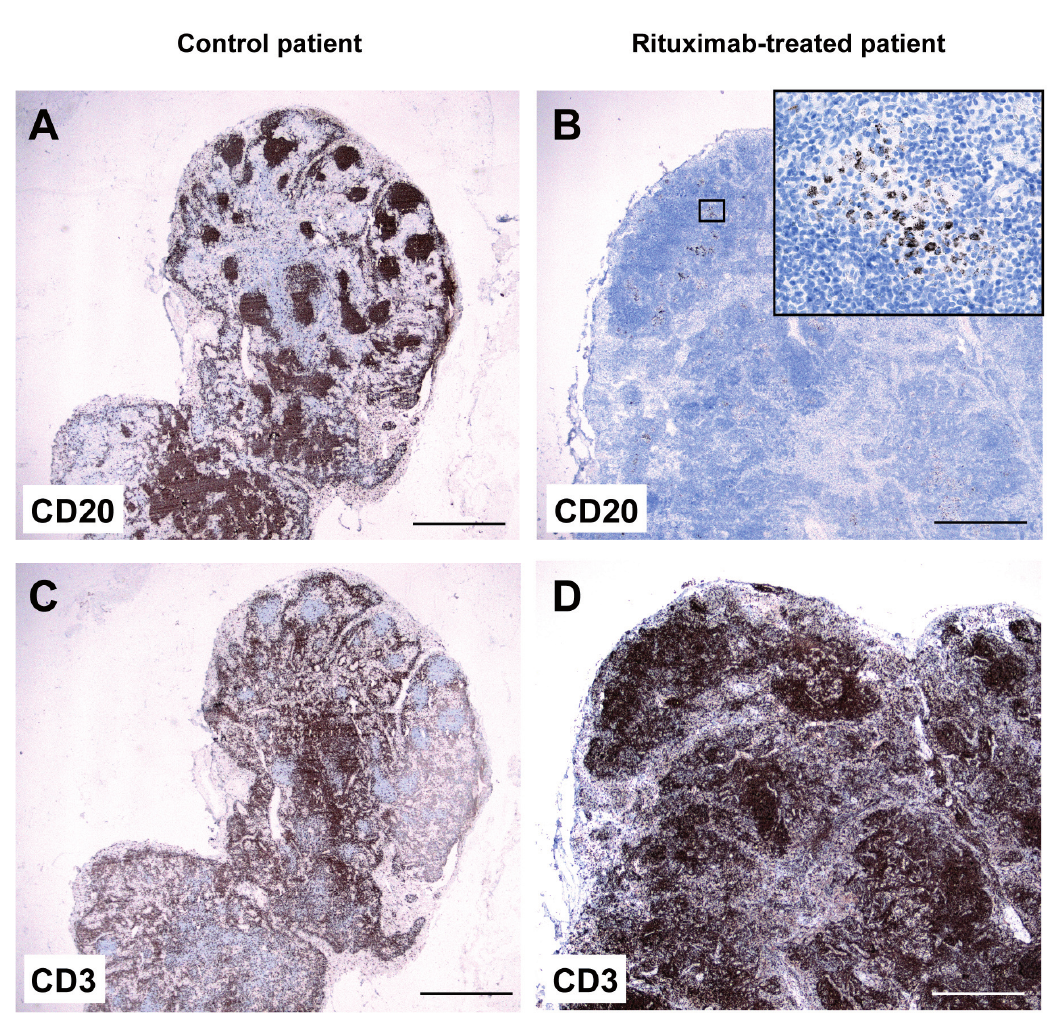
Figure 5. Absence of CD20 + B cells in lung-associated lymph node from a patient treated with rituximab. A lung-associated lymph node from a control patient ( left ) and from a rituximab-treated patient ( right ) were stained with anti-CD20 ( A – B ) or anti-CD3 ( C – D ) antibodies, and contrastained with hematoxylin. Both patients were diagnosed with lung adenocarcinoma. The small box in B indicates the area that is magnified in the upper right insert. The black dots in B represent anthracotic pigment in macrophages. Main images: 20 × magnification; scalebar = 1 mm. Upper right insert in B : 400 ×